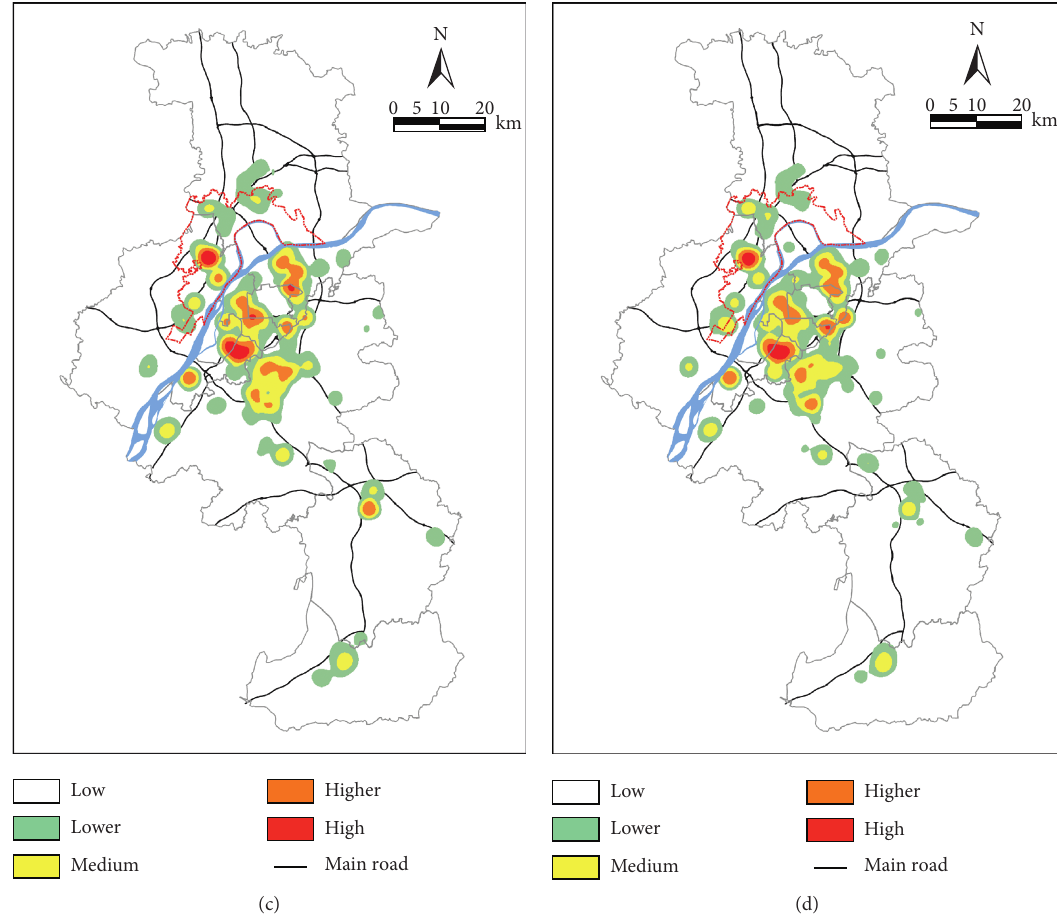
Figure 3: Results of kernel density estimation: (a) 2008–2010; (b) 2011–2013; (c) 2014–2016; (d)